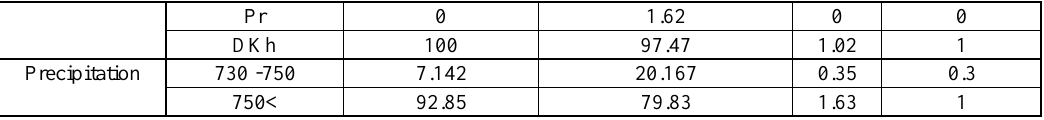
Table 1. Spatial relationships between each factor and landslide and fuzzy membership values